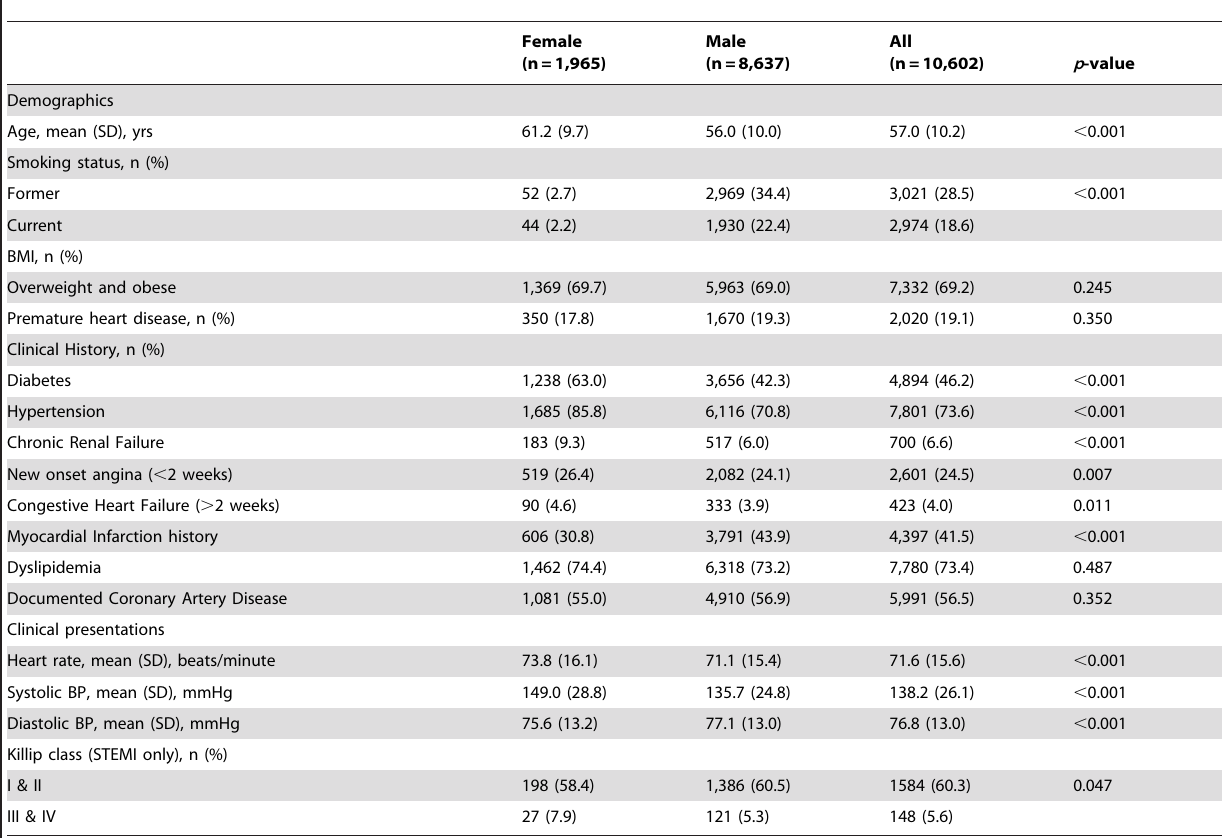
p -values are calculated for gender, comparing all sub-categories except the unknown category for all variables. All p-values are calculated using the Chi-square test unless stated.